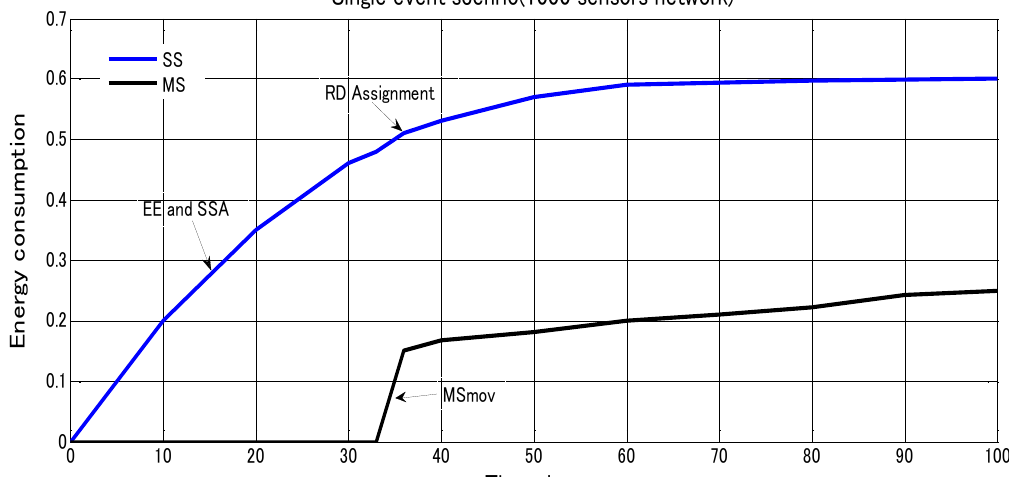
Figure 11. Energy consumption of SS and MS based on the spent time lots under a single- event scenario with totally 1,000 sensors randomly distributed over a 100*100 network